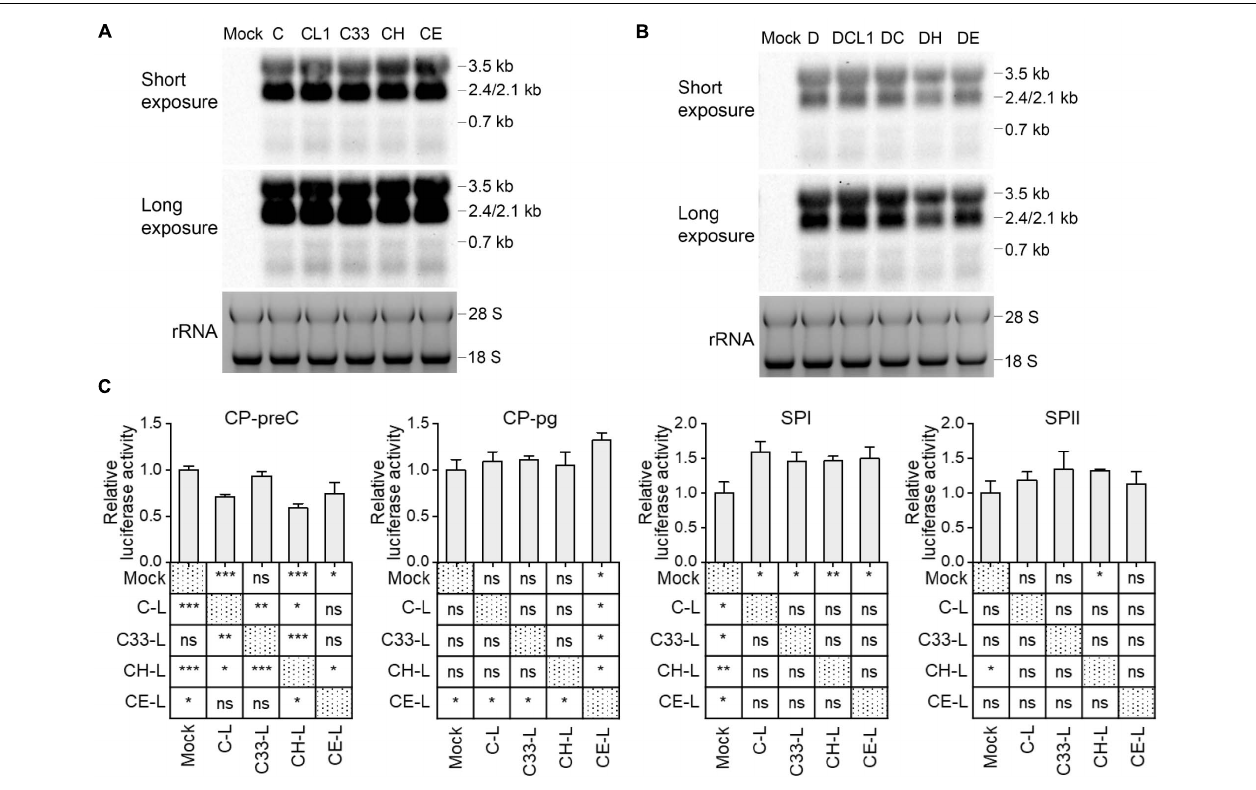
FIGURE 5 | Impact of preS1 N-terminal sequences on HBV transcription. Northern blot of intracellular HBV RNAs from HepG2 cells transfected with 1.3-mer HBV genome from C-derived (A) or D-derived (B) strains, with ethidium bromide stained rRNA serving as a loading control. (C) HepG2 cells were transiently co-transfected with HBV promoter plasmid (CP-pg, CP-preC, SPI, or SPII), which controls the expression of firefly luciferase, LHBs expression plasmid (C-L, C33-L, CH-L, or CE-L) and normalizing plasmid pRL-TK. Three days after transfection, the promoter activities were determined by dual luciferase reporter assay. Relative luciferase activity was calculated as firefly/renilla rate and further normalized as fold change to Mock. (C) The histograms show mean values from one representative experiment; the bars indicate Standard Deviation. The p values were determined using Student’s t test; ns represents no significant, * p < 0.05, ** p < 0.01, *** p < 0.001. CP, core promoter; SPI, surface promoter I; SPII, surface promoter II; rRNA, ribosomal